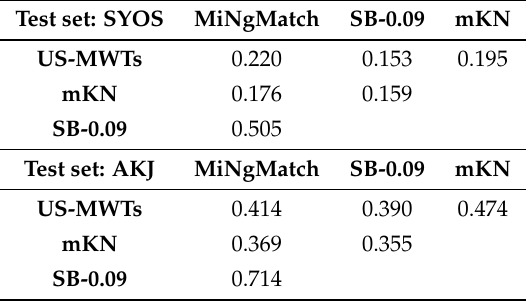
Table 12. Error comparison (Jaccard index).